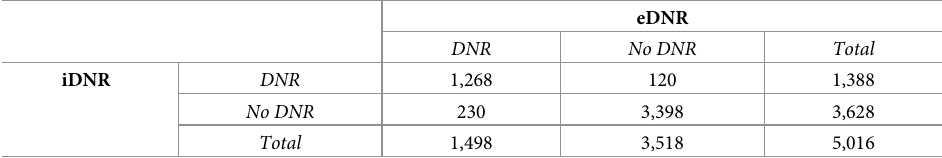
Table 2. Contingency table of eDNR and